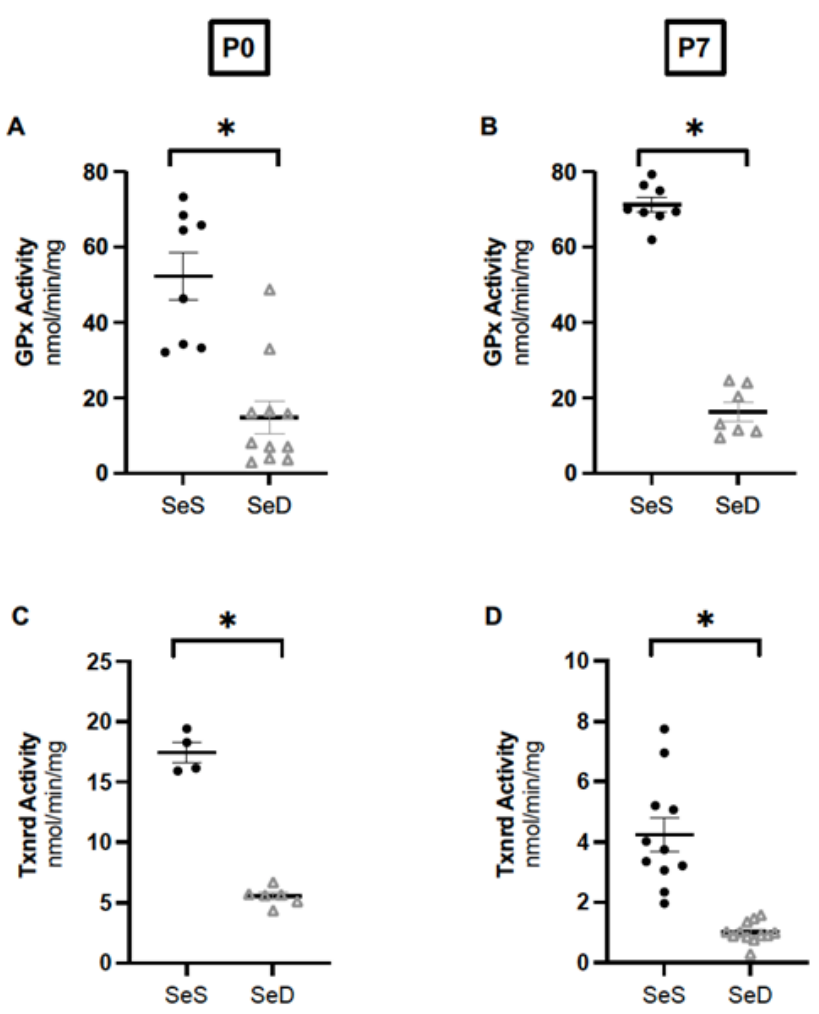
Figure 3. Neonatal Se deficient mice demonstrate decreased activity of GPx and Txnrd at postnatal day 0 and 7. C57Bl/6 mice were placed on diets that differed only in Se content, either 0.4 ppm or <0.01 ppm of sodium selenite, through pregnancy and lactation. Pulmonary organ homogenate was evaluated on day of birth (P0) and postnatal day 7 (P7). ( A ) Glutathione peroxidase activity levels at P0, (nmol/minute/mg of protein) ( B ) Glutathione peroxidase activity level at P7, (nmol/minute/mg of protein). ( C ) Thioredoxin reductase activity levels at P0, (nmol/minute/mg of protein). ( D ) Thioredoxin reductase activity level at P7, (nmol/minute/mg of protein). N = 4–12 for all groups. Data are presented as mean (±SEM), * p < 0.05 vs. SeS control by Students two-sided t -test.